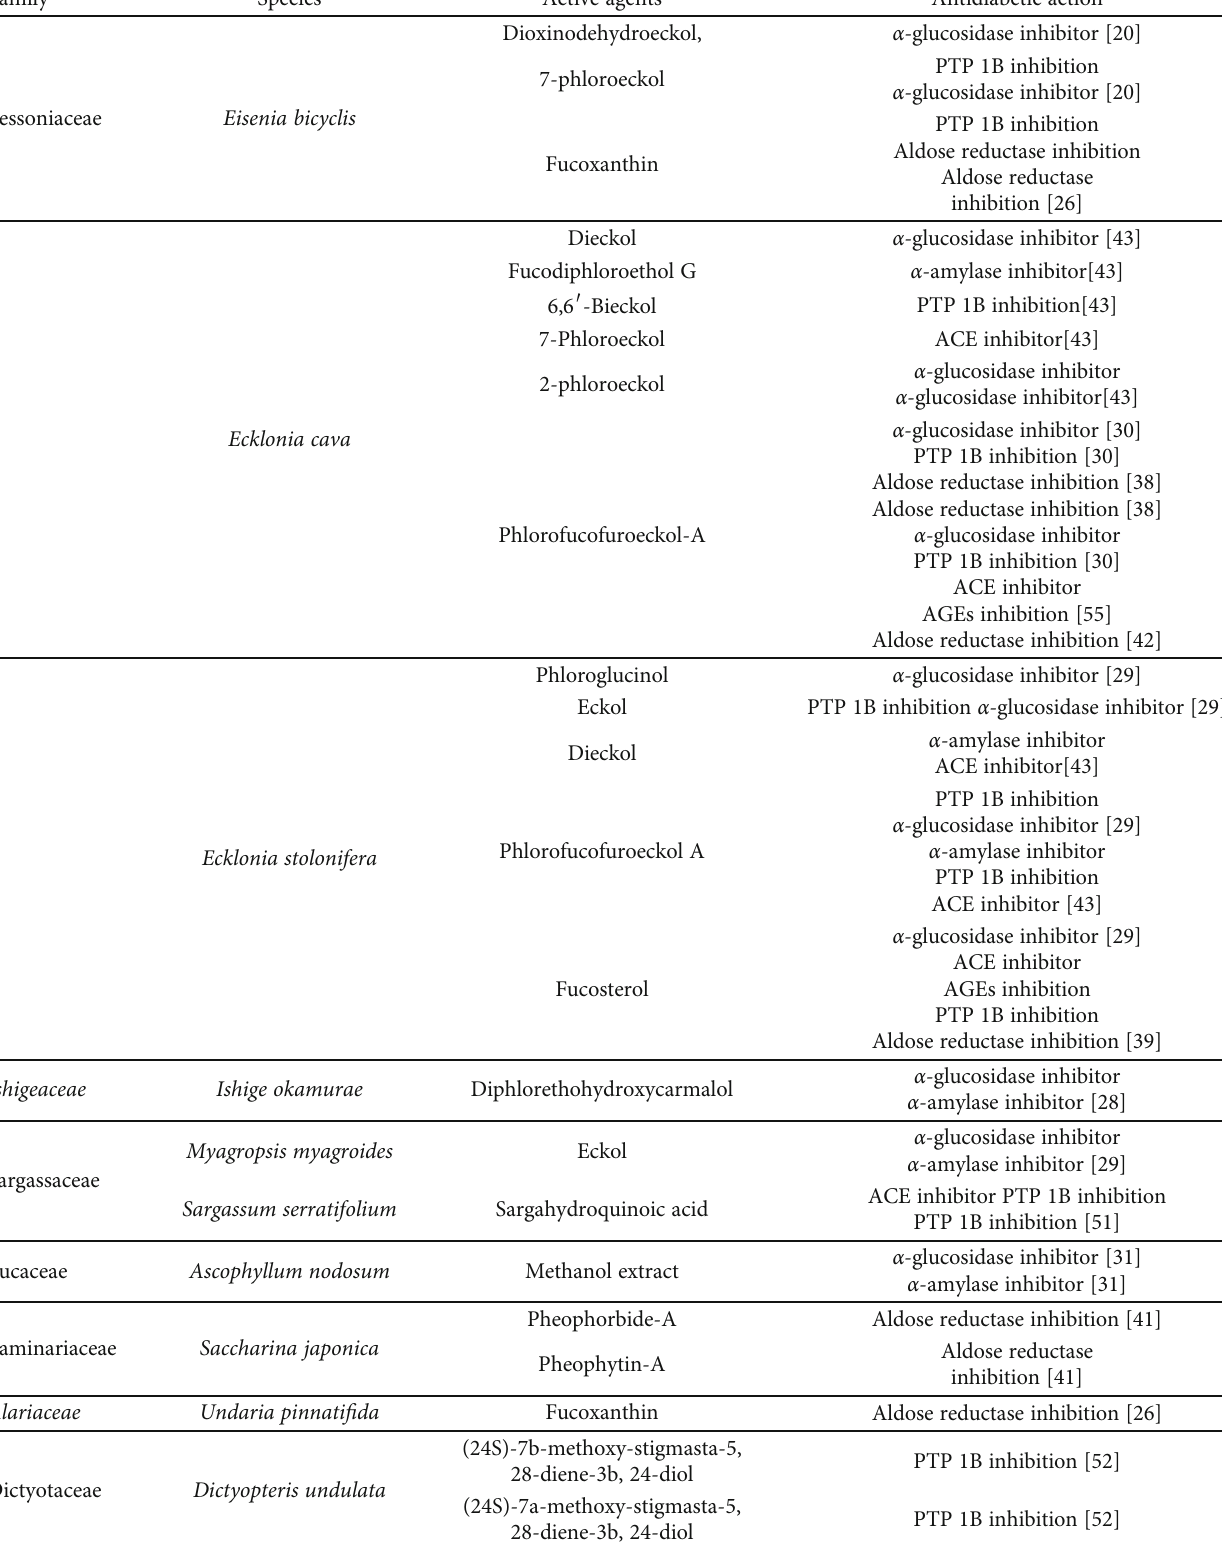
Table 1: Summary of tested brown algae and possible active agents responsible for the antidiabetes